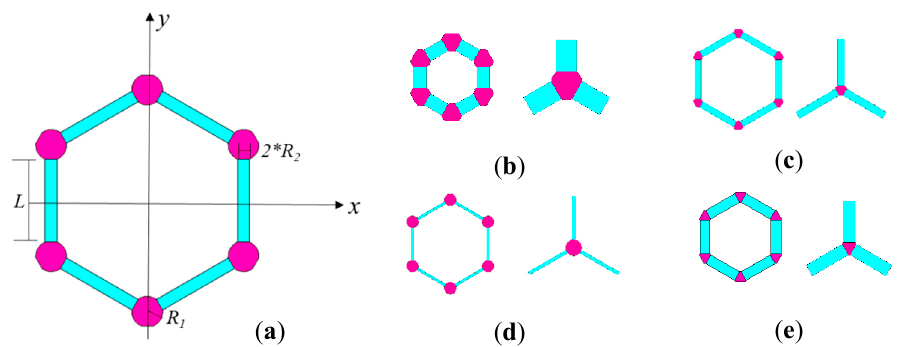
Figure 2. The geometrical parameters and typical examples in the finite plane element model of graphene.